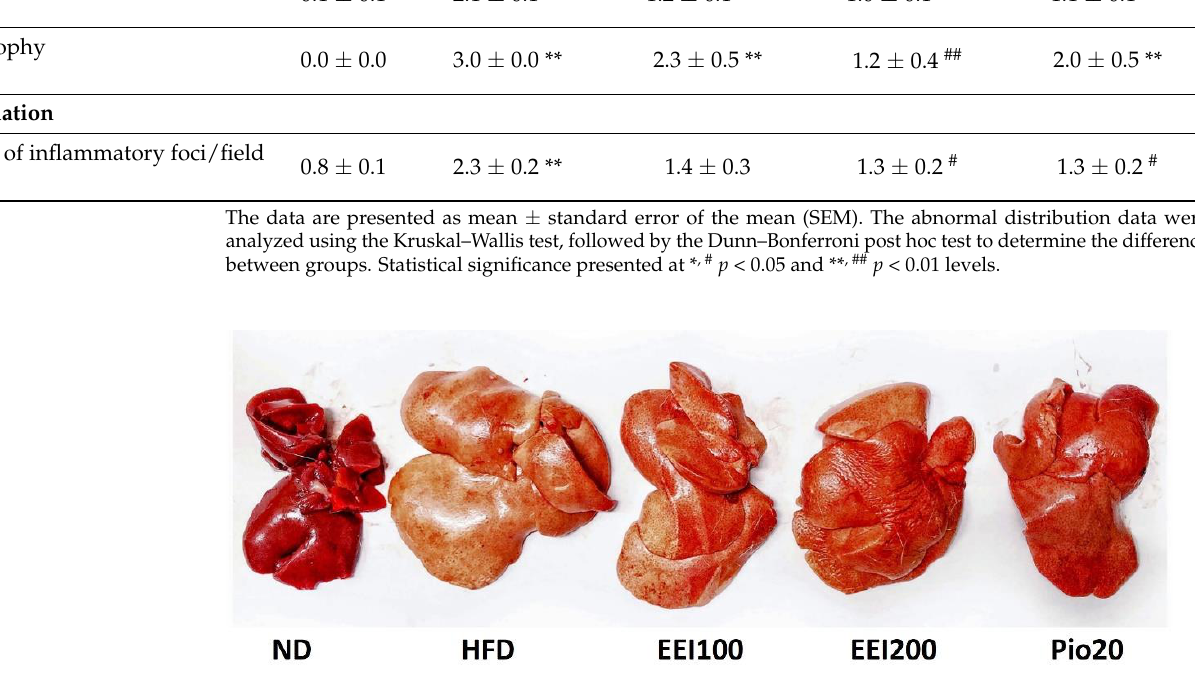
Figure 5. The effect of 2-week feeding EEI on macroscopic liver appearance. ND = Normal diet-fed rats treated with vehicle; HFD = High fat diet-fed rats treated with vehicle; EEI100 = HFD-fed rats treated with 100 mg/kg/day of EEI; EEI200 = HFD-fed rats treated with 200 mg/kg/day of EEI; Pio = HFD-fed rats treated with 20 mg/kg/day of pioglitazone.